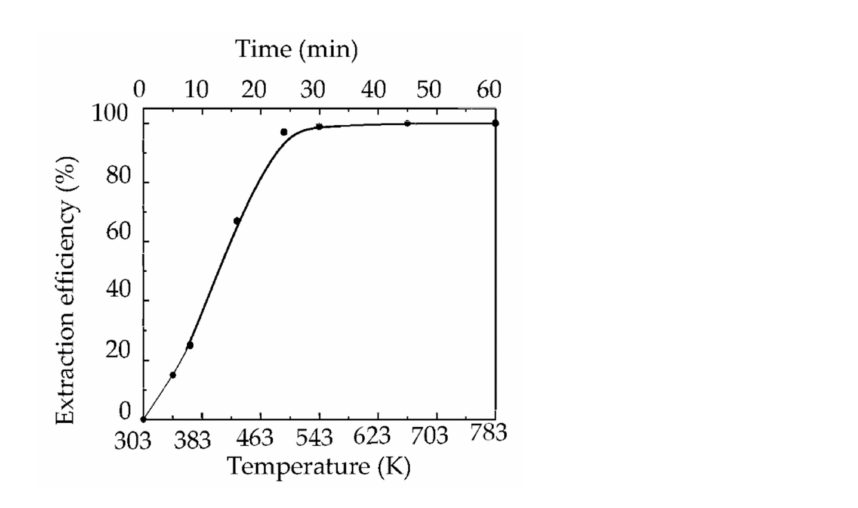
Figure 1. Temperature course for extraction of copper from the scrap Cu/ITO thin film with